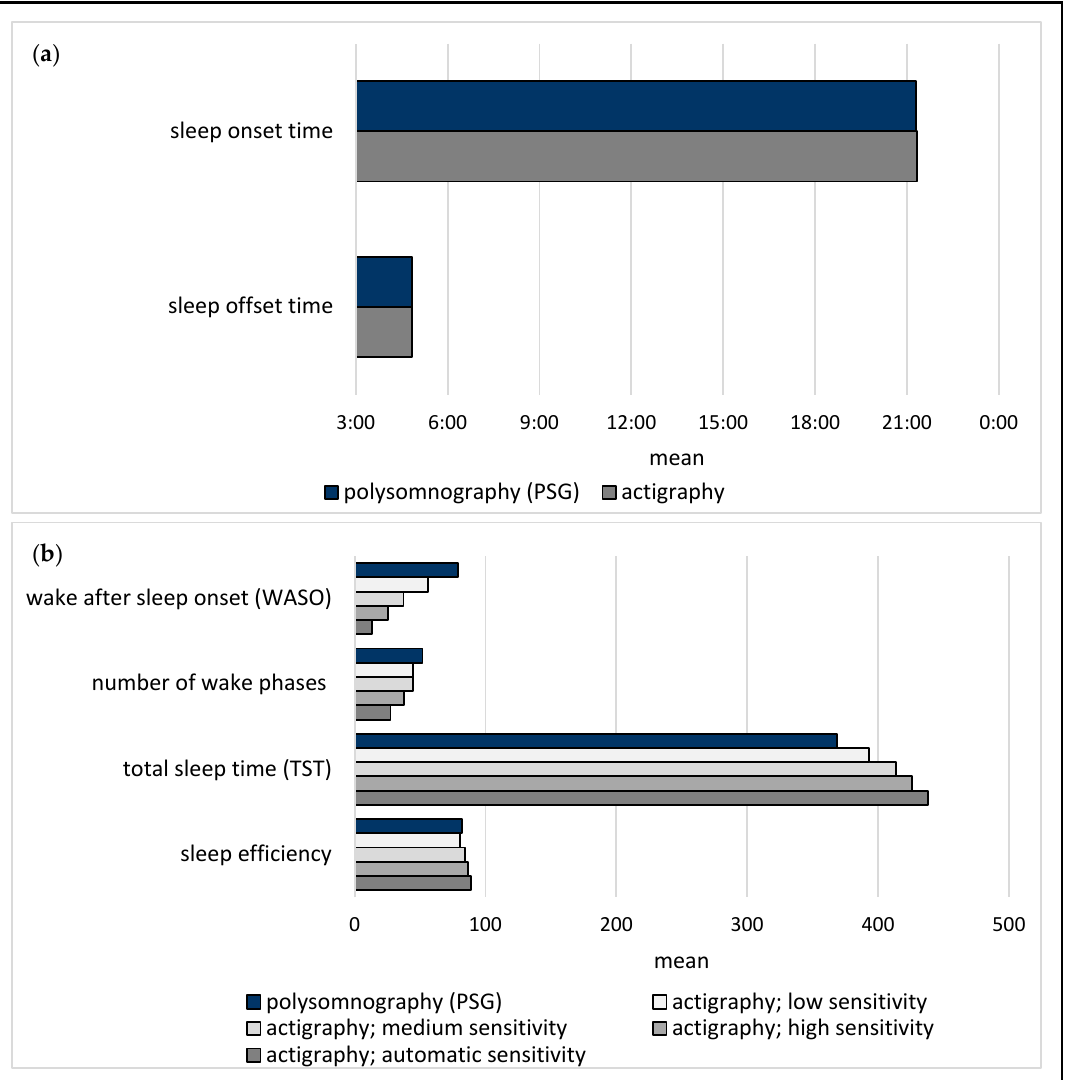
Figure 2. Mean polysomnography (PSG) and actigraphy values for the investigated parameters, for which no sensitivity levels ( a ) and those for which different sensitivity levels ( b ) were considered.